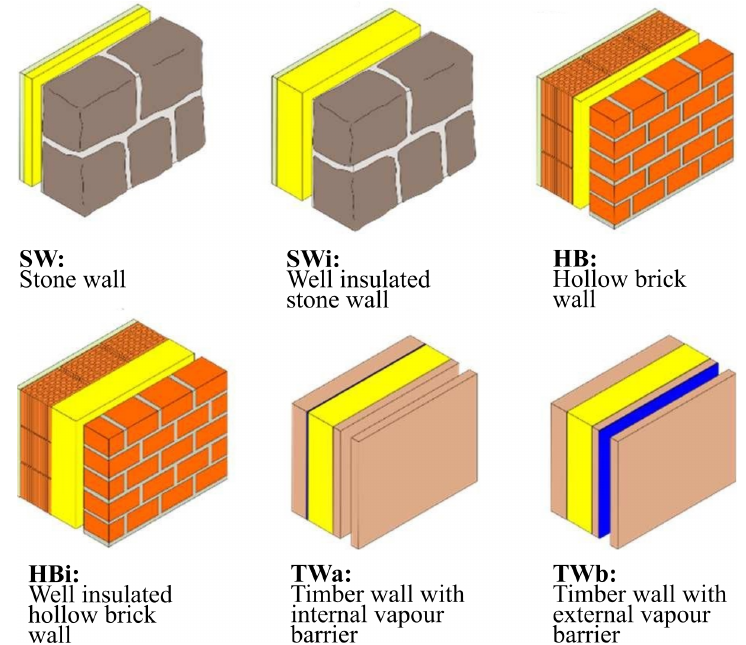
Figure 6. Building envelopes considered in the study. The exterior surface is on the